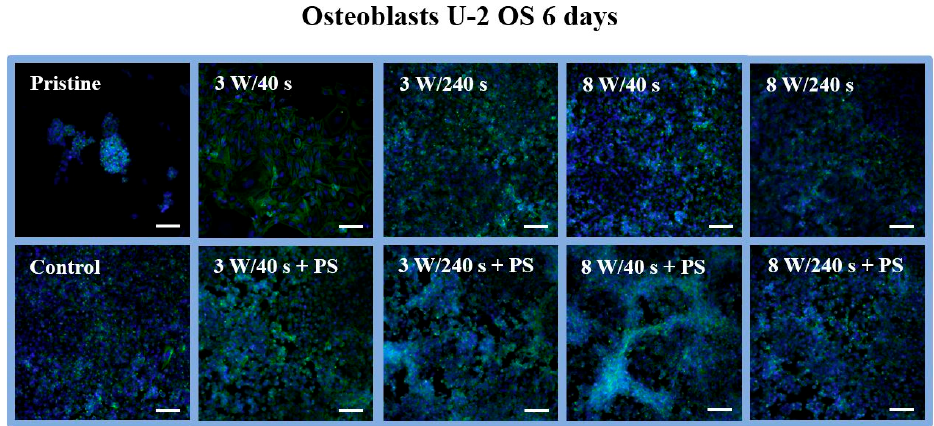
Figure 10. Fluorescence microscopy images of human osteoblasts (U-2 OS) at 6 days post-seeding on FEP (pristine), FEP matrices treated using plasma with 3 and 8 W (40 and 240 s) and subsequently coated with a honeycomb-like pattern formed from PS. As a control, a glass coverslip was used. Nuclei stained with DAPI are in blue, F-actin labeled with phalloidin-Atto 488 is in green. The scale bars represent 100 µm.